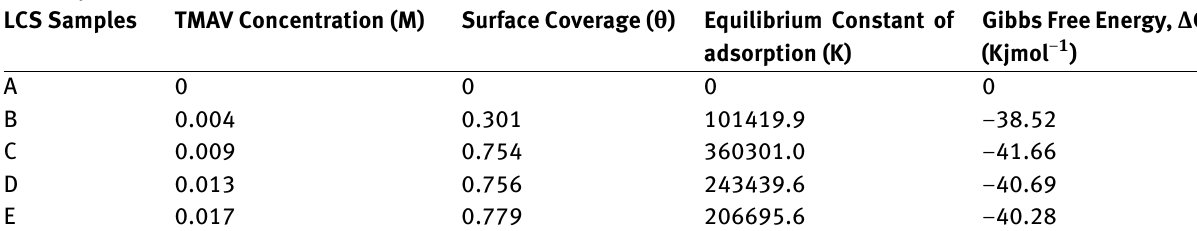
Figure 10: Adsorption isotherm plots (a) Frumkin isotherm and (b) Freundlich isotherm in HCl solution Table 6: Results of Gibbs free energy ( ∆G ) and equilibrium constant of adsorption ( K ads ) in for TMAV adsorption in H 2 SO 4 and HCl solution H 2 SO